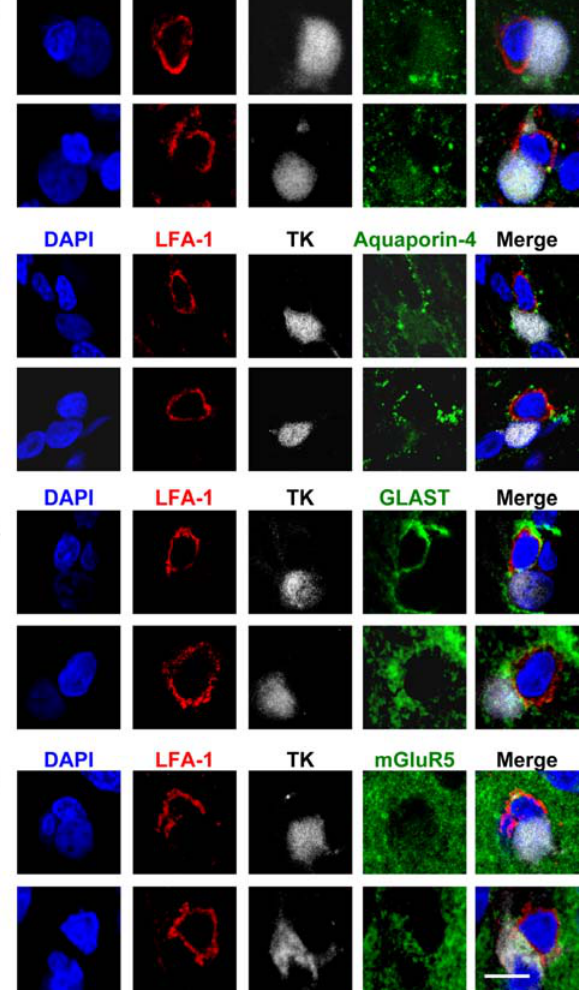
Figure 8. The distribution of other membrane proteins (Connexin 43, Aquaporin-4, GLAST, mGluR5) enriched within the plasma membrane of astrocytes show no obvious pattern of distribution in relation to the T cell immunological synapse. Confocal 0.5 m m optical sections of two immunological synapses are shown stained for each of the membrane proteins. Staining for LFA-1 (red), TK (grey) and DAPI (blue) were combined either with Connexin 43 (green in A), Aquaporin-4 (green in B), GLAST (green in C) or mGluR5 (green in D). The superposition of all four channels is also shown for each synapse (Merge). There was no specific polarization of any of these membrane proteins. Scale bar=10 m m.